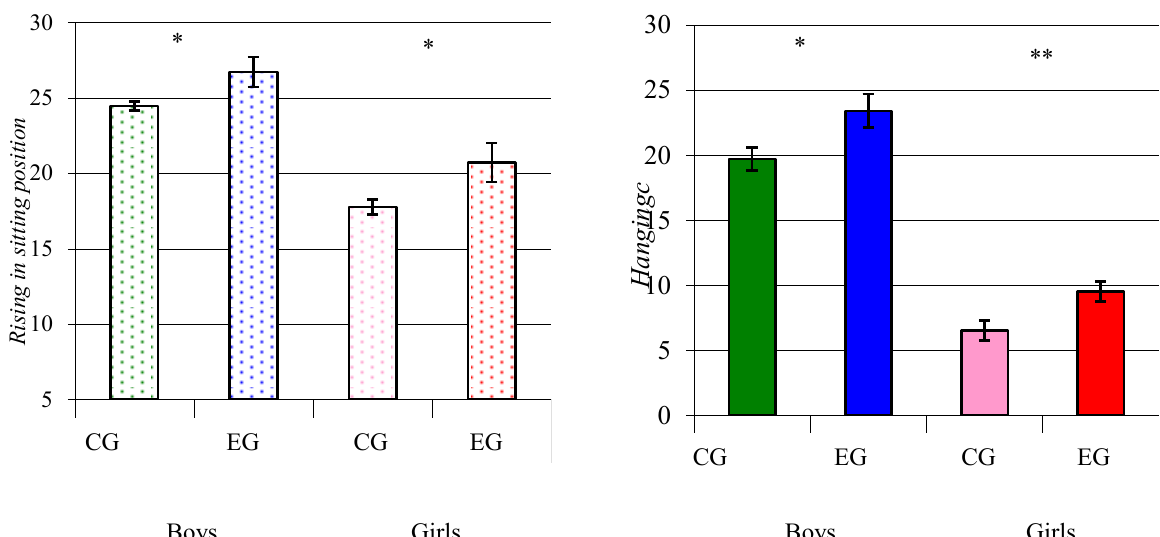
Fig.1 Dynamic and static endurance of countryside teenagers of 7 th form in control (CG) and experimental (RG) groups